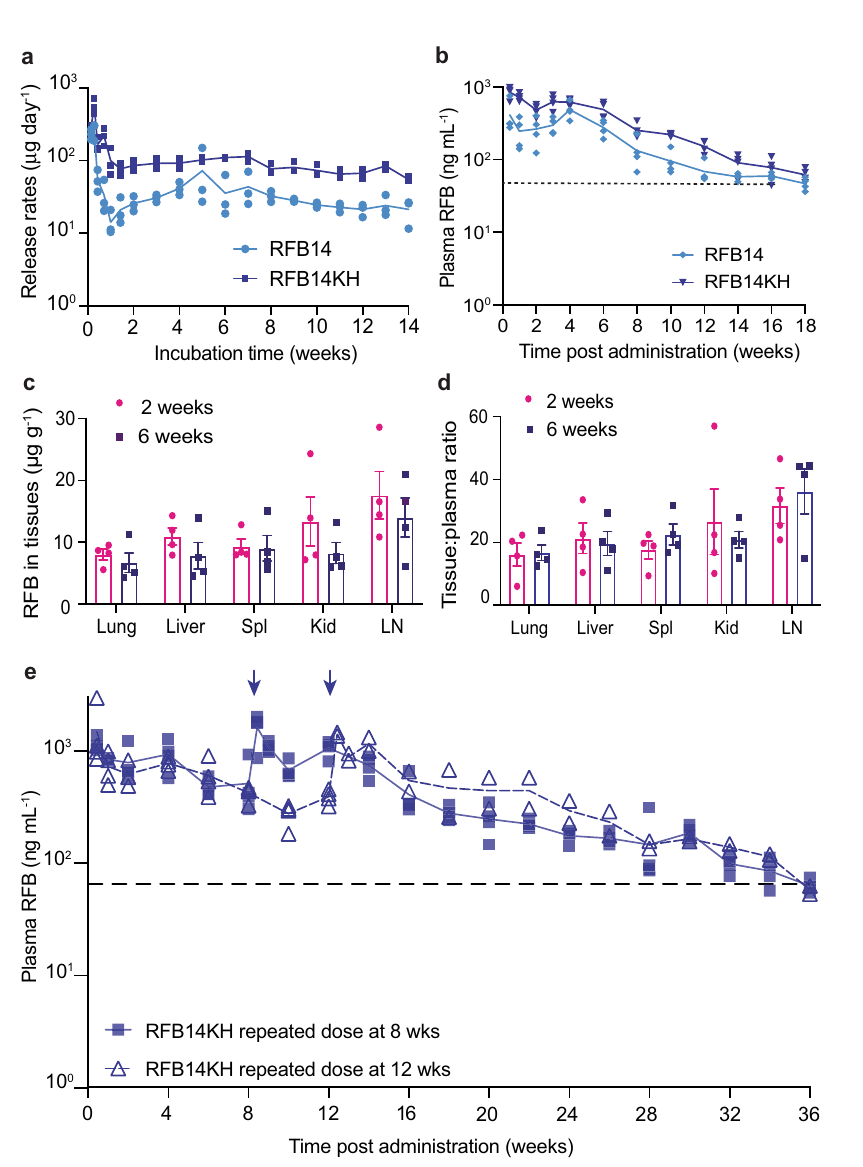
Fig. 3 | Improved RFB release by formulations containing uncapped acid- ending PLGA. a Daily in vitro RFB release from LA-RFB formulations containing acid-ending PLGA (LA:GA 50:50, MW 13.5kDa) without Kolliphor ® HS 15 (RFB14) or with Kolliphor ® HS 15 (RFB14KH), n =3 per formulation. b In vivo RFB plasma con- centrations in BALB/c after a single subcutaneous injection (50 μ L) of RFB14 or RFB14KH ( n =4). The dottedline indicates RFB MIC. c RFBtissue concentrations at 2 and 6 weeks post administration of RFB14KH (50 μ L) in BALB/c mice; n =4 per time point, mean±SEM. d Tissue to plasma ratio of RFB concentrations at 2 and